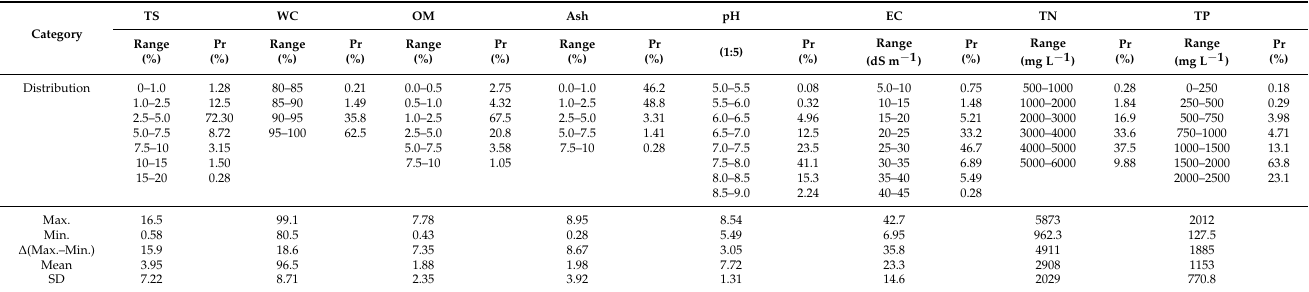
Table 1. Distribution and descriptive statistics of physical and chemical properties of RSS collected from 37 public livestock waste recycling centers.